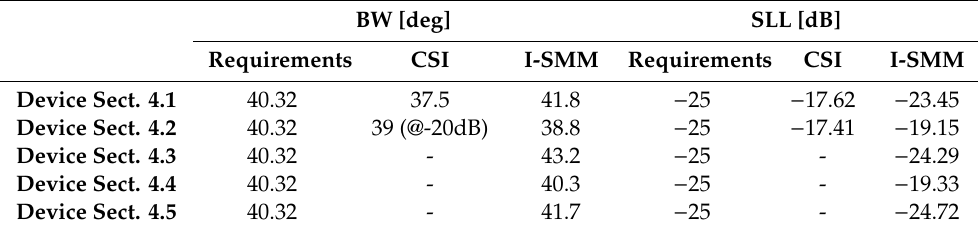
Table 1. Quantitative comparison of performance of di ff erent kinds of synthesized